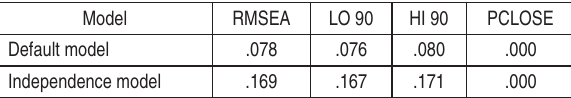
Table 3. Root mean square error of